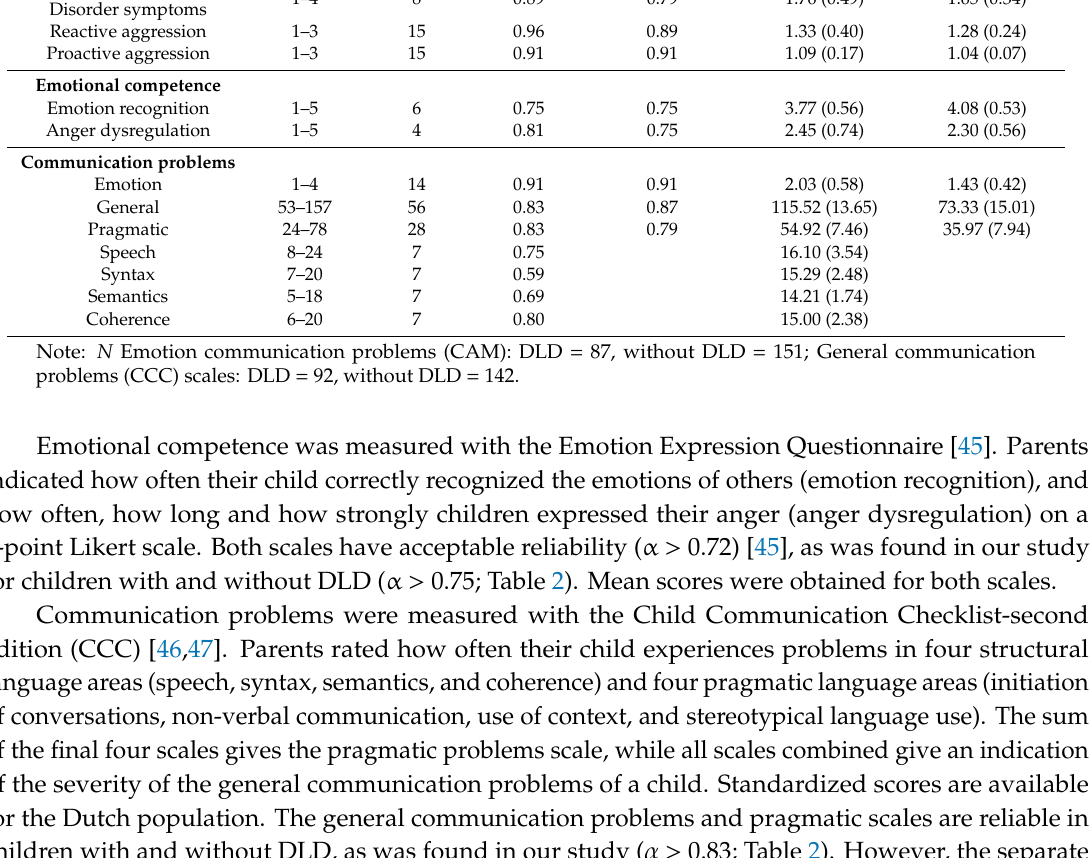
With DLD Without DLD n = 98 n =